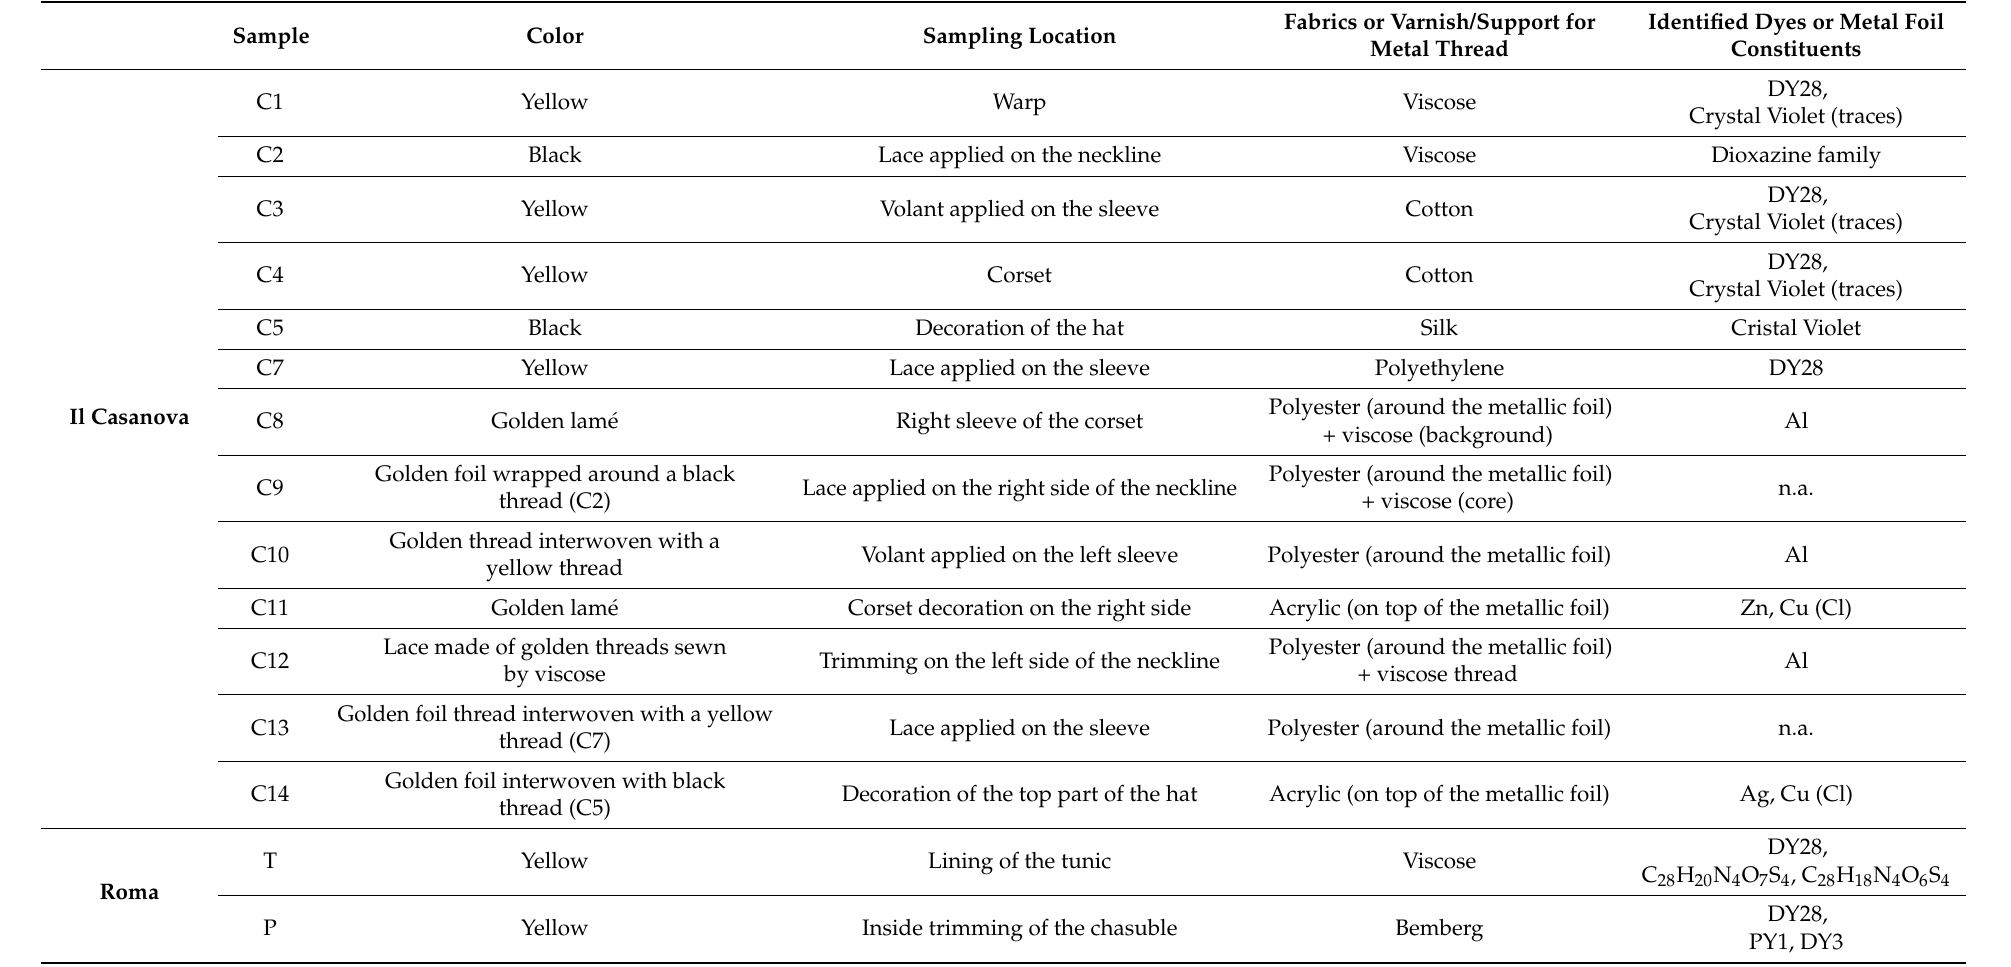
Table 5. Fabrics, dyes, and metal foil constituents identified in all the samples analyzed (n.a. = not